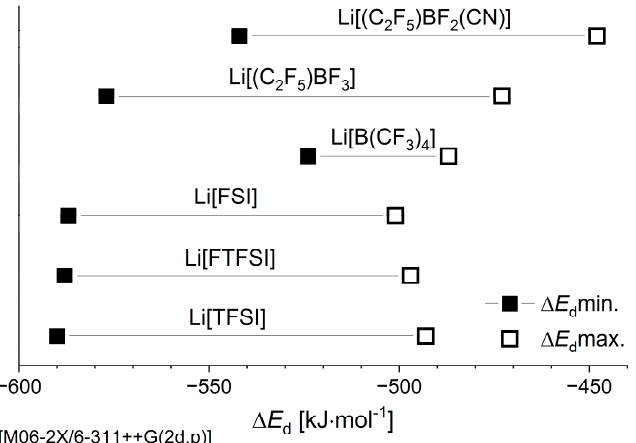
Figure 2. Minimum and maximum electronic dissociation energies of the three Li-salt systems from this work. The values for lithium bis(flurosulfonyl)imide Li[FSI], lithium (fluorosulfonyl)(trifluoromethanesulfonyl)imide Li[FTFSI], and lithium bis(trifluoromethanesulfonyl)imide (Li[TFSI]) are from reference [40].